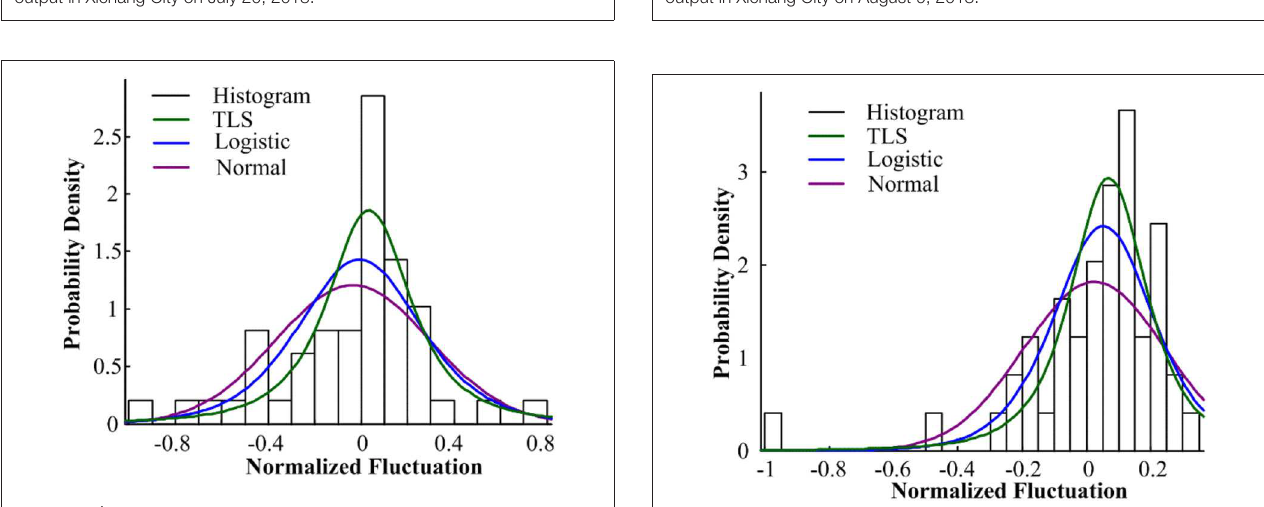
FIGURE 5 | Probability distribution fitting of random components of PV output in Xichang City on August 9,